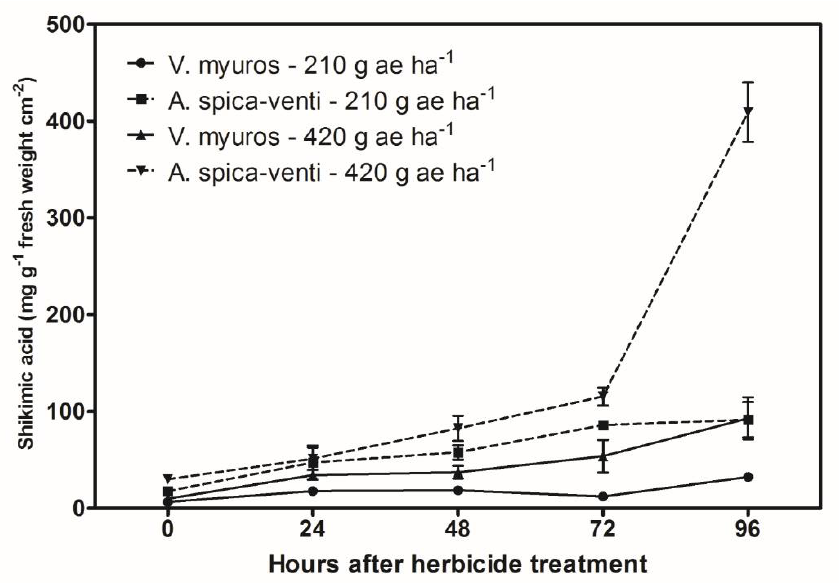
Figure 3. Accumulation of shikimic acid in leaves of Vulpia myuros and Apera spica-venti following treatment with glyphosate (210 and 410 g ae ha − 1 ). Vertical bars are presenting standard errors of the means.